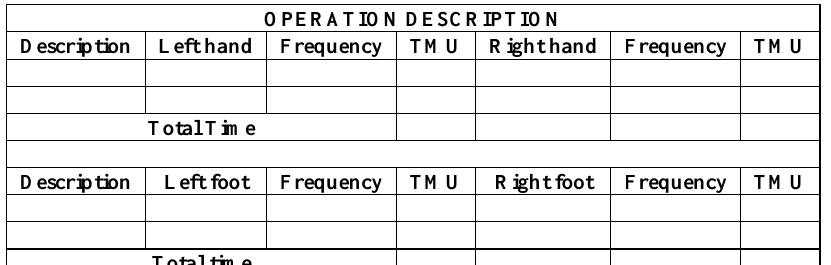
Table 3: Standard fills for MTM